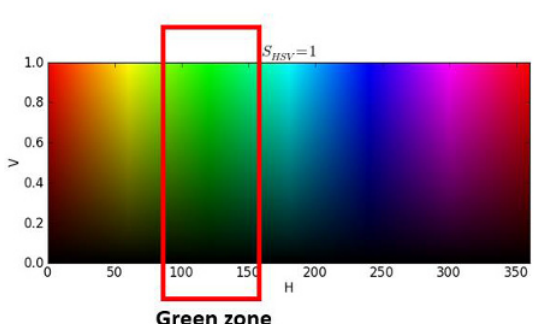
Fig. 3. Extracting Green zone from the HSV color space.